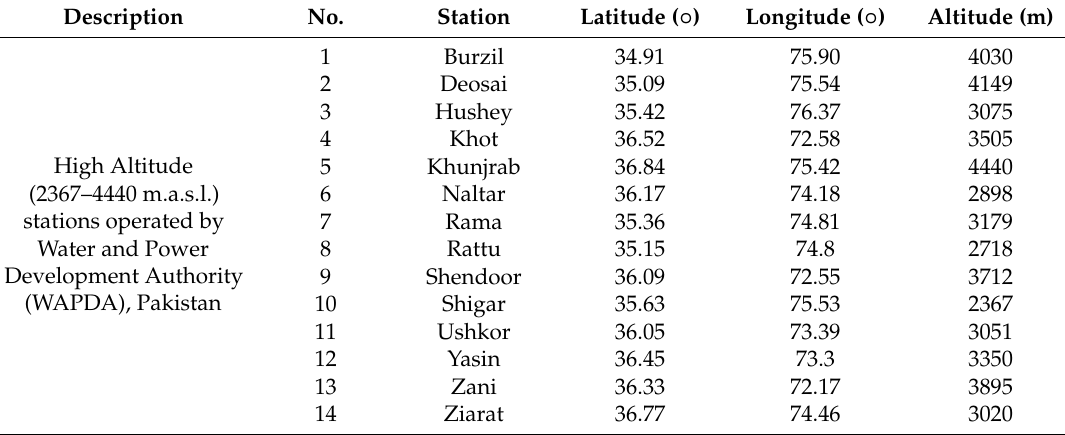
Table 1. Geographical attributes of the precipitation gauge